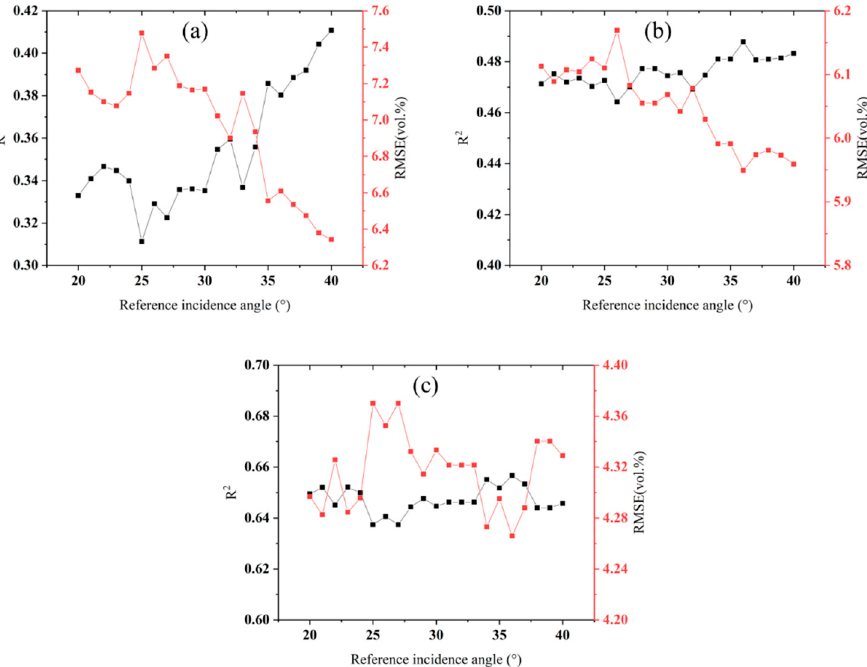
Figure 12. SMC estimation accuracy based on ratio method with different reference incidence an ‐ gels. ( a ) RVI; ( b ) LAI; ( c ) NDVI.